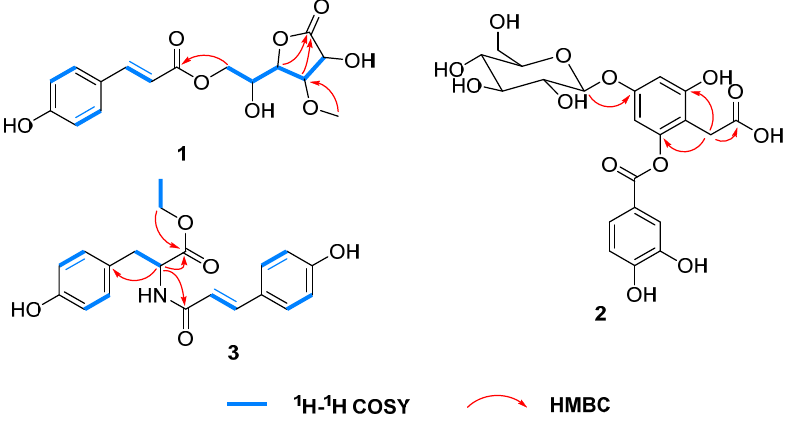
Figure 2. Key COSY and HMBC correlations of 1 – 3 .